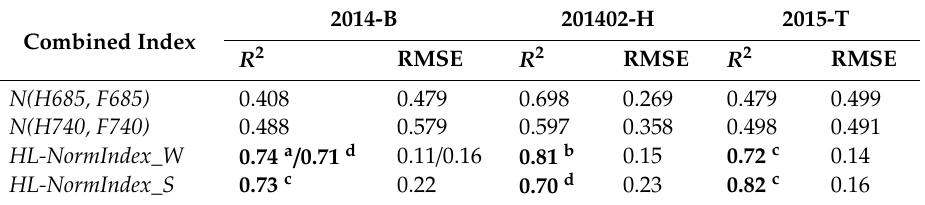
Table 4. Comparison of estimated LNC results between the published combined indices in Du et al. and the FW / GSI-based NCI H-F in the same form as NDVI based on the data from 2014- and 2015-year. (SI of N (H685, F685) and N (H740, F740) can be calculated with Equations (10) and (11),